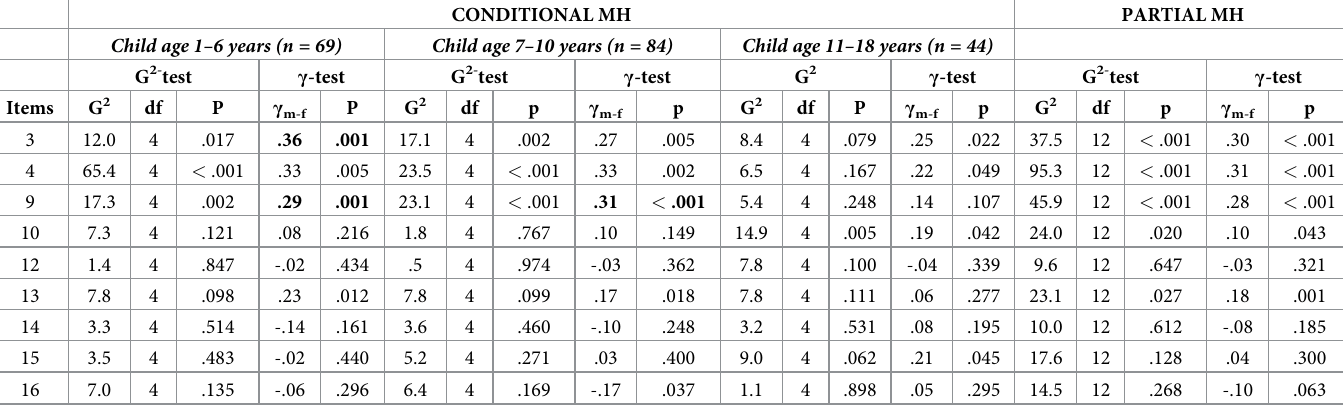
Table 4. Test for marginal homogeneity between mothers’ and fathers’ responses conditioned by child